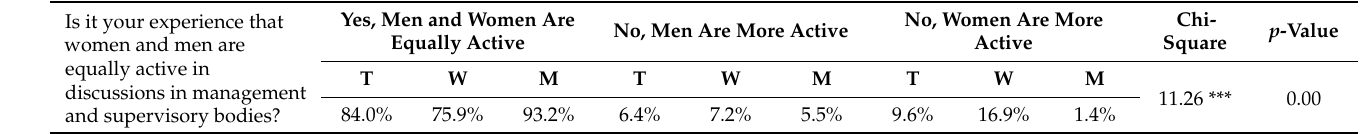
Table A4. Descriptive statistics and mean comparison between women and men who responded to P32—Is it your experience that women and men are equally active in discussions in management and supervisory bodies?